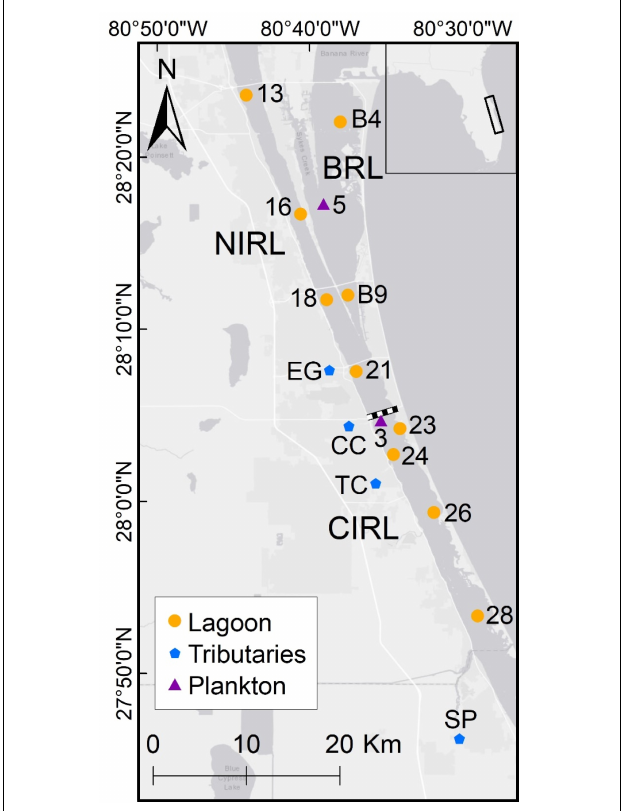
FIGURE 1 | Map of Indian River Lagoon (IRL) showing tributaries South Prong Saint Sebastian River (SP), Crane Creek (CC), Turkey Creek (TC), and Eau Gallie River (EG). Boundary between North IRL (NIRL) and Central IRL (CIRL) shown with dashed line north of CC. IRL stations 13, 16, 18, 21, 23, 24, 26, and 28 plus Banana River Lagoon (BRL) stations B4 and B9 were sampled by St. Johns River Water Management District [SJRWMD] (2020b). Phytoplankton were sampled by Phlips et al. (2021). Sebastian Inlet to the Atlantic Ocean is ∼ 5 km east of the mouth of SP. Inset map shows IRL and BRL along central east coast of Florida. Station coordinates in Supplementary Table 1